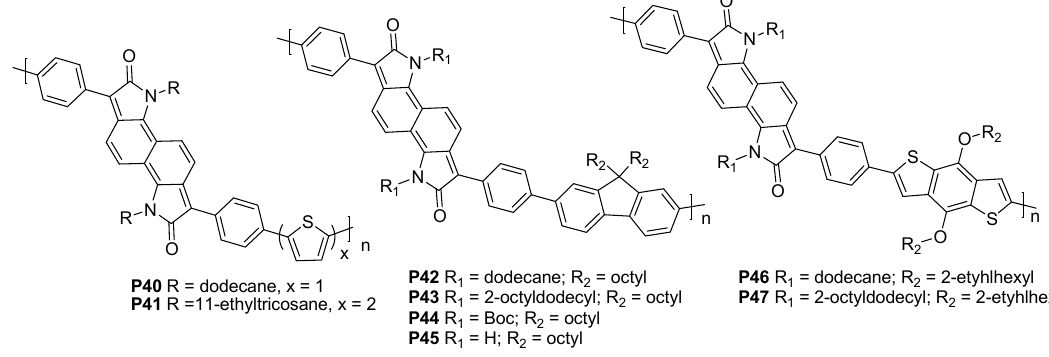
Figure 7. Chemical structure of polymers based on NDP.